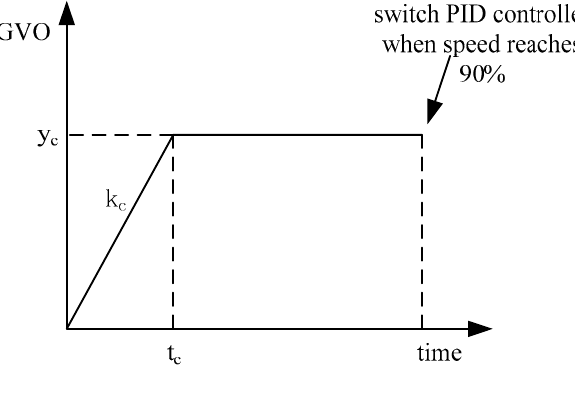
Figure 10. One-stage DGVC law.